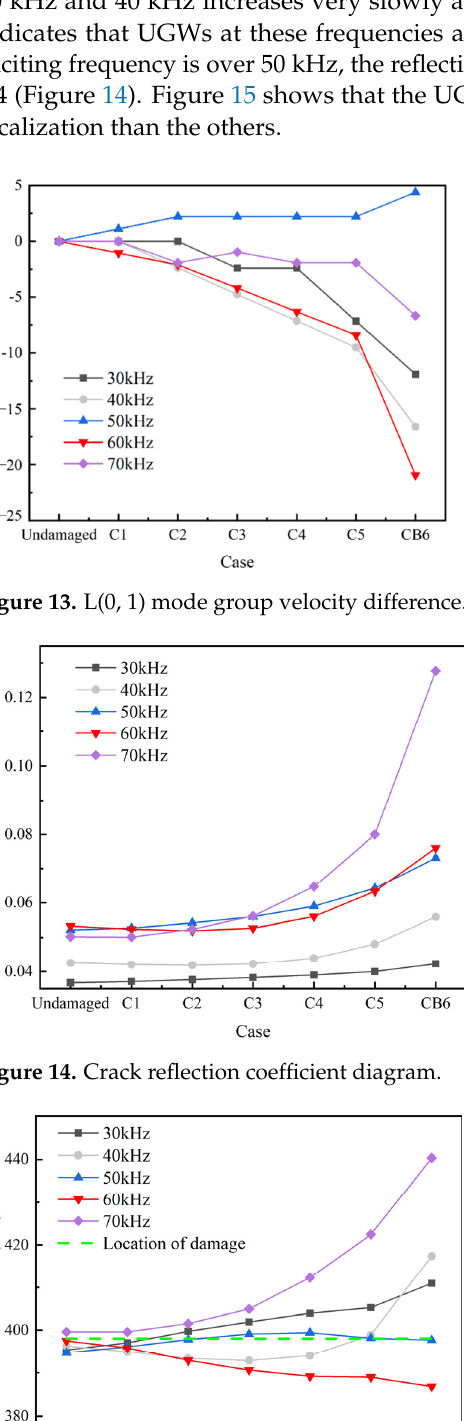
( b ) Figure 12. Time domain envelopes of signals at 60 kHz. ( a ) Time domain envelopes of full signals. ( b ) Time domain envelopes of residual signals. Again, the first round-trip echo in time domain is selected to calculate the linear pa-